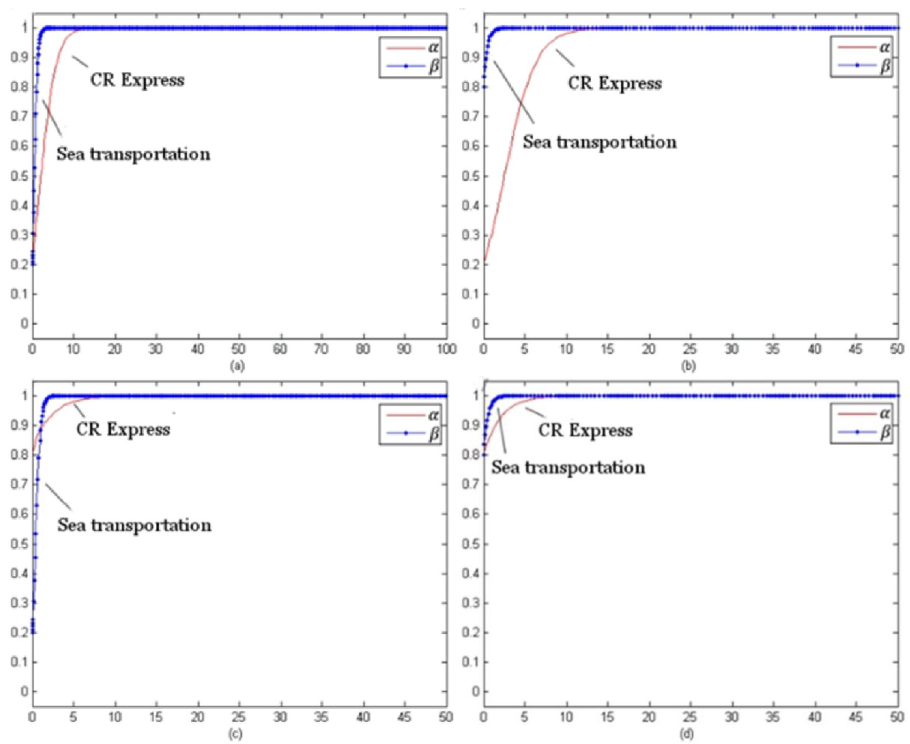
Fig 8. Game evolution trend of auto parts transportation competition (without